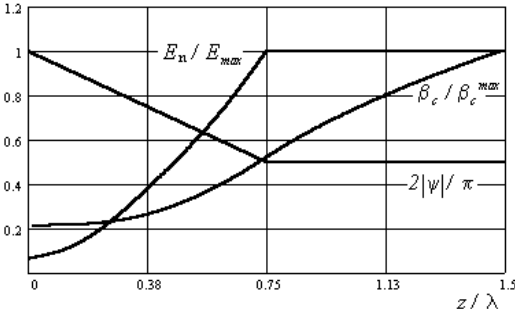
FIG. 4. Acceleration structure parameters versus longitudinal coordinate.